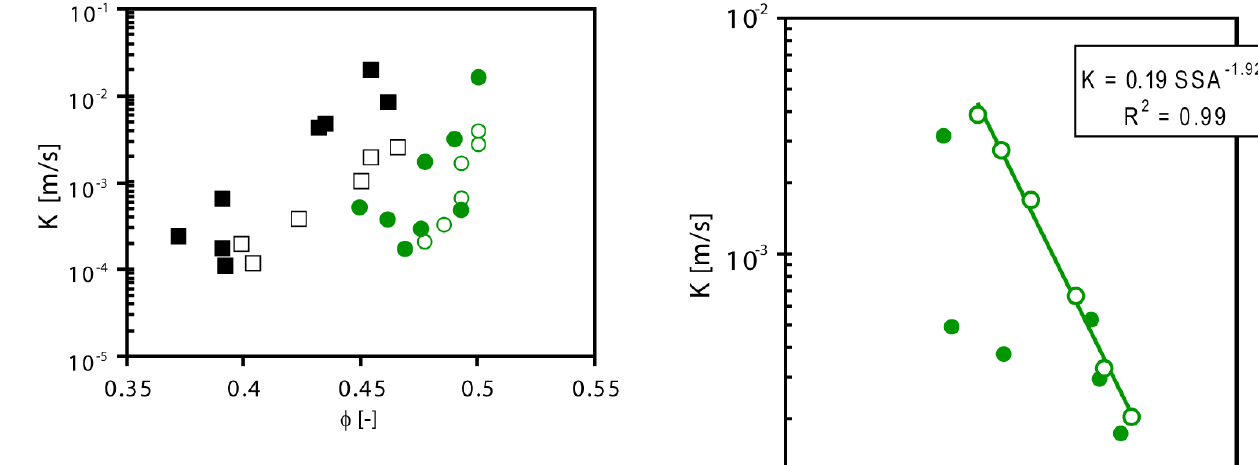
Fig. 4. Plot of the saturated hydraulic conductivity K versus poros- ity φ for all of the samples considered in this study. Black squares represent compacted and unsieved samples, while full green circles represent uncompacted and unsieved samples. Sieved, well sorted sands are represented as non-solid black squares for compacted, and non-solid green circles for uncompacted samples. Fig. 5. Plot of the saturated hydraulic conductivity K versus specific surface area (SSA) for non-compacted samples having grain sizes smaller than 2mm. Green solid circles denote unsieved samples, while non-solid green circles represent sieved sand fractions. The power law fit refers only to the data from sieved sand